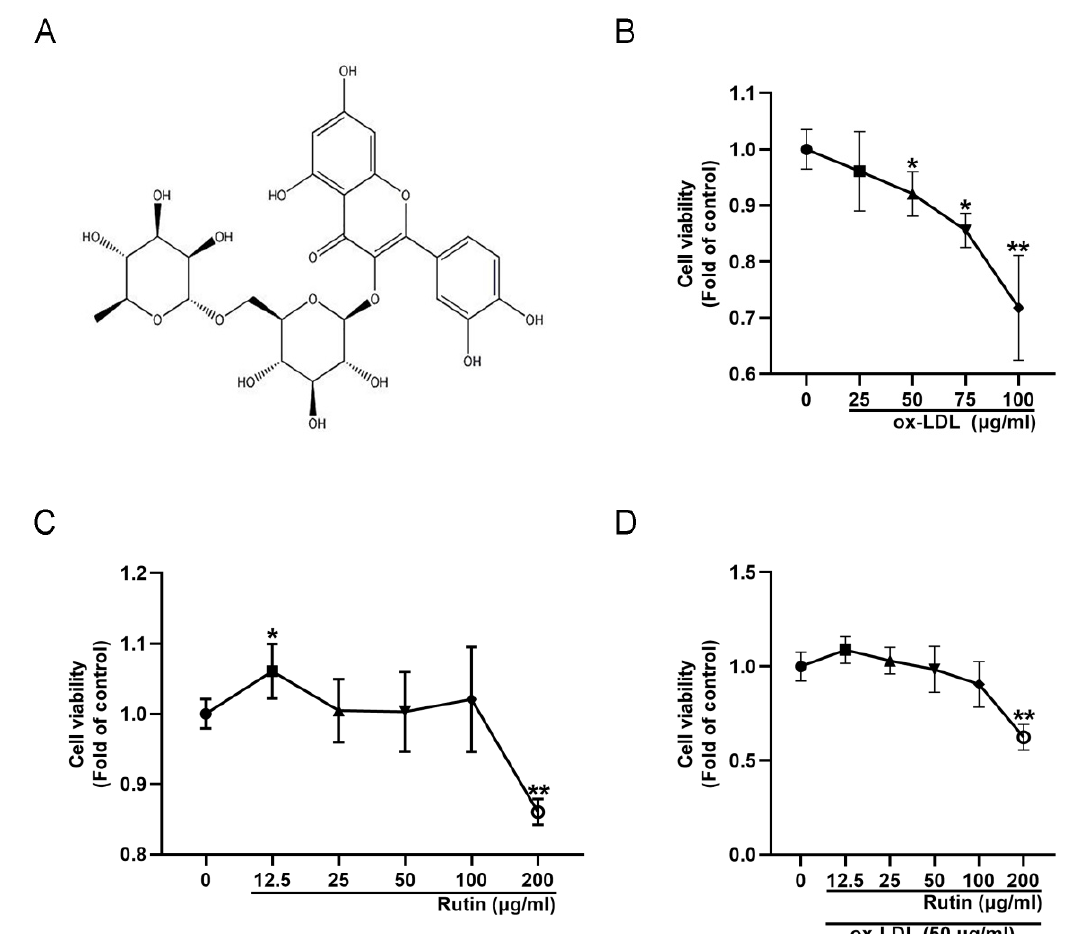
Figure 1. Rutin can help RAW264.7 cells survive after being exposed to ox-LDL. ( A ) Rutin ′ s chemical formula. ( B ) Viability of RAW264.7 cells treated with ox-LDL. ( C ) RAW264 cell viability after rutin treatment. ( D ) Viability of RAW264.7 cells treated with rutin and ox-LDL. * p < 0.05; ** p < 0.01. Data are provided as mean ± SD.